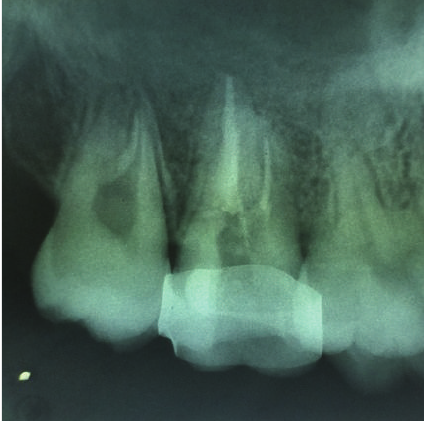
Figure 12: Radiograph showing 3 mm of intracanal space prepara- tion with respect to 27.